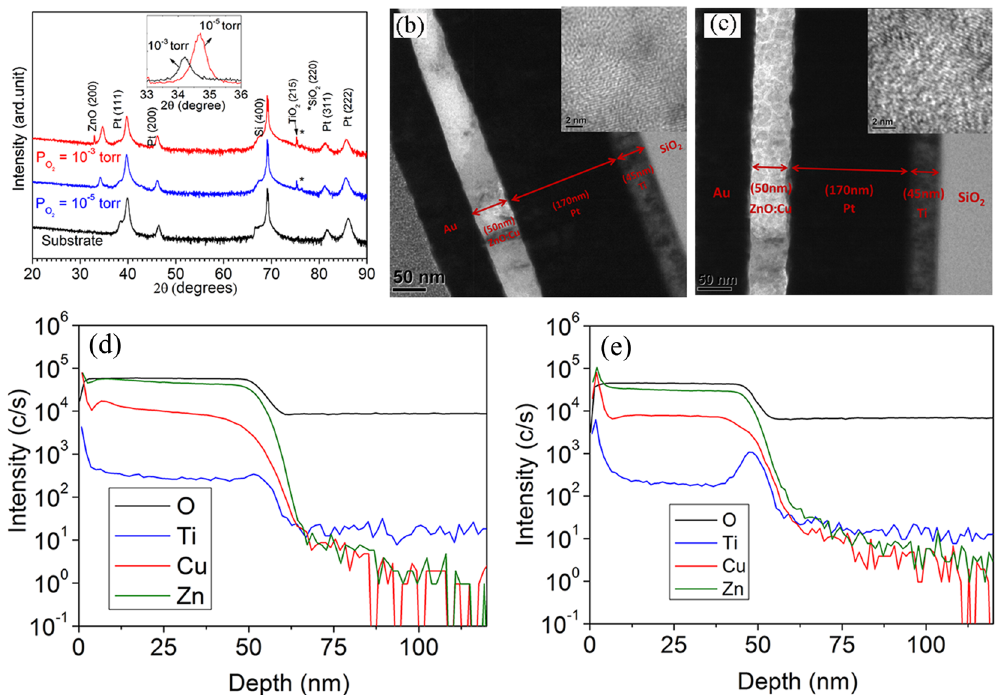
Figure 1. ( a ) XRD patterns of Cu-ZnO films deposited under PO 2 = 10 − 3 torr and PO 2 = 10 − 5 torr. The inset shows the enlarged region in a narrow scale close to (002) peak. TEM image of Cu-ZnO film deposited under ( b ) PO 2 = 10 − 3 torr; ( c ) PO 2 = 10 − 5 torr. The insets show the high-resolution TEM image of ZnO:Cu films. ( d ) and ( e ) are SIMS spectra of Cu-ZnO deposited at PO 2 = 10 − 3 and 10 − 5 torr,